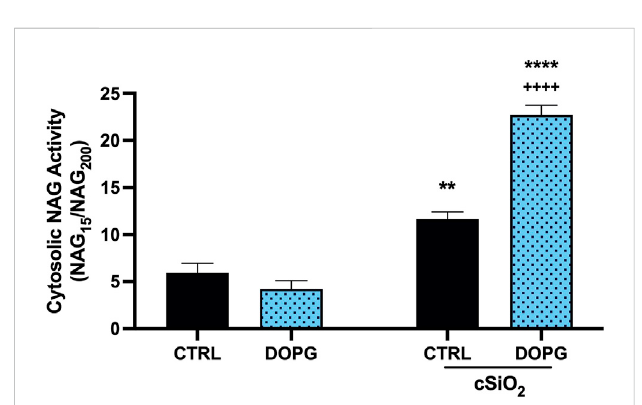
FIGURE 5 DOPG increases silica-induced LMP. BMdM treated with and without DOPG for 1 h before silica application for 24 h. BMdM extracted by digitonin (15 μ g/mL) and cytosolic NAG activity measured with fl uorescent NAG substrate. NAG values from 15 μ g/mL digitonin extraction normalized to complete lysis by 200 μ g/mL digitonin to indicate cytosolic NAG activity. Data expressed as mean ± SEM , n = 3. Analyzed by two-way ANOVA with Tukey's multiple comparisons test. ** p < 0.01 and **** p < 0.0001 compared to control untreated cells. ++++ p < 0.0001 compared to silica-exposed